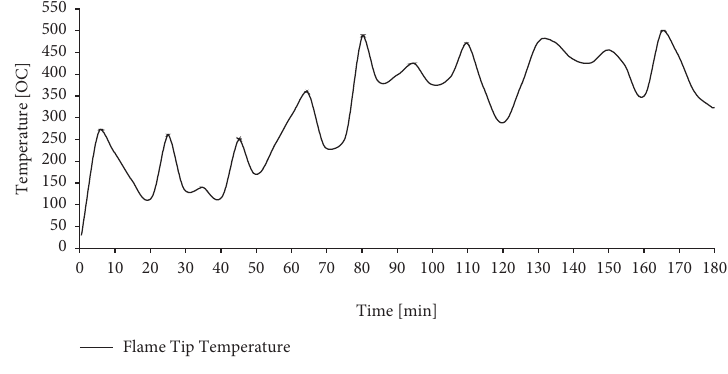
Figure 3: Time-dependent flame tip temperature. Table 2: Boundary conditions used in the CFD